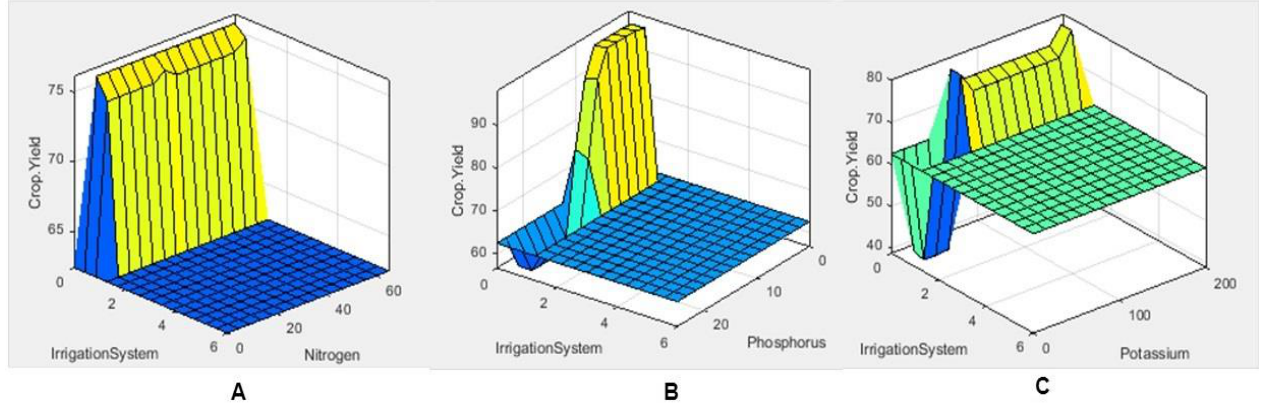
Figure 8. Impact of input variables in crop yield model .